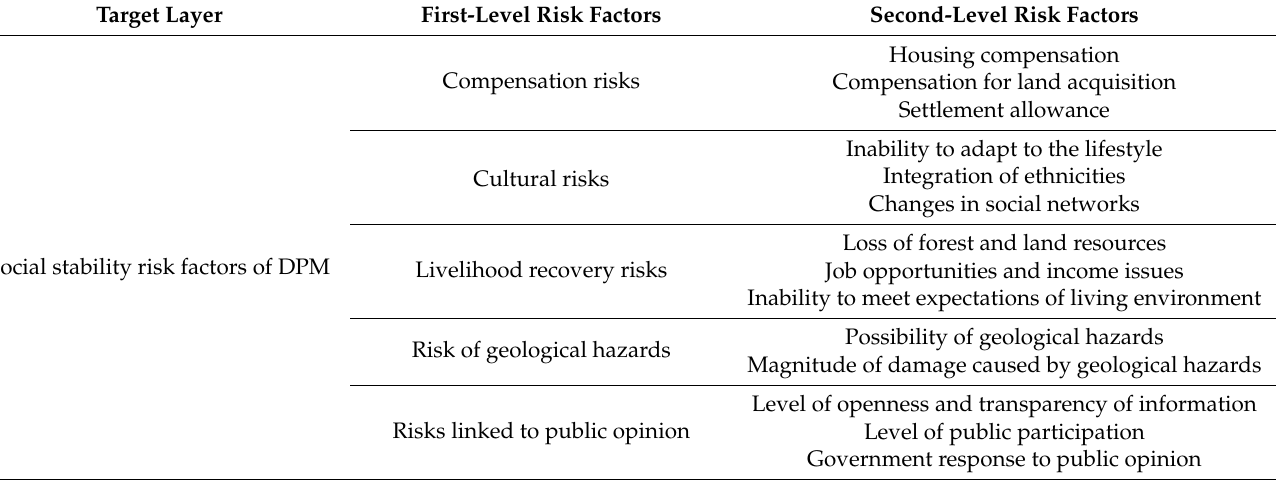
Table 1. Social stability risk factors for disaster-preventive